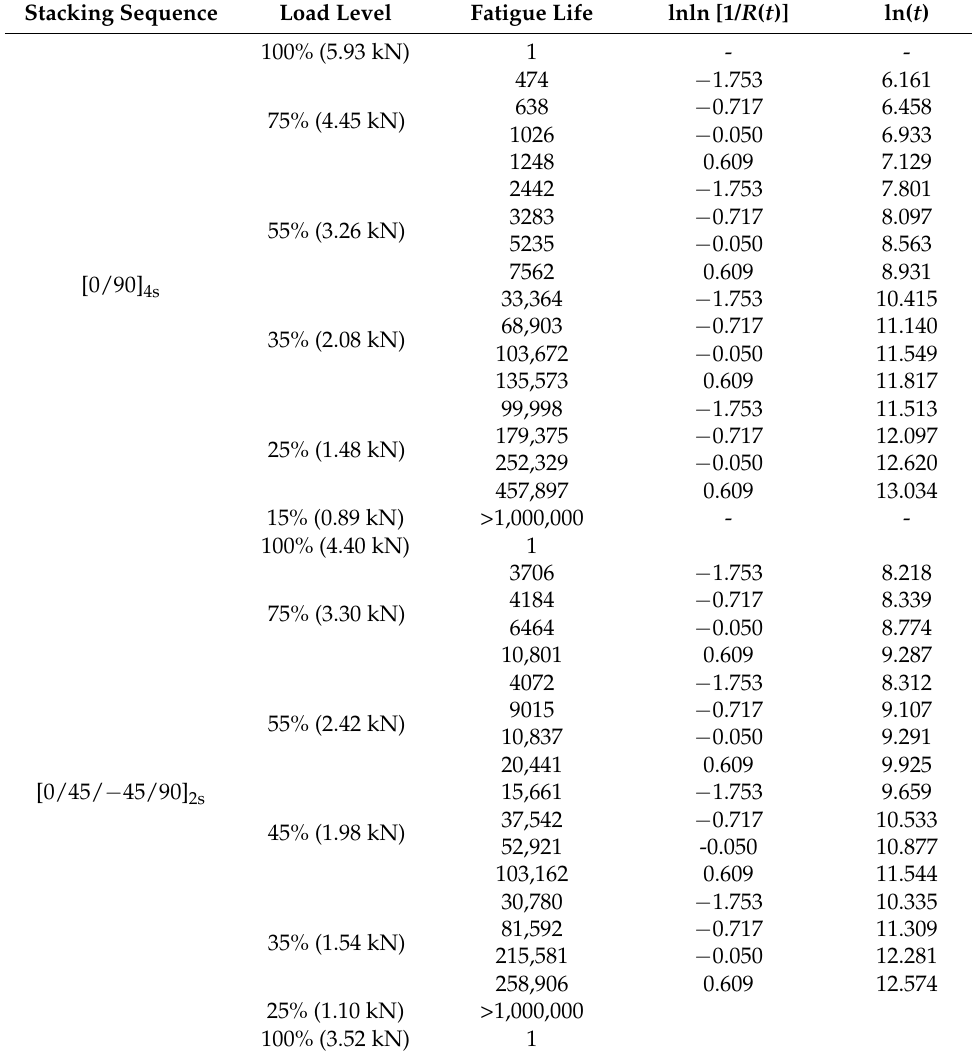
Table 5. Fatigue life under different load levels with different stacking